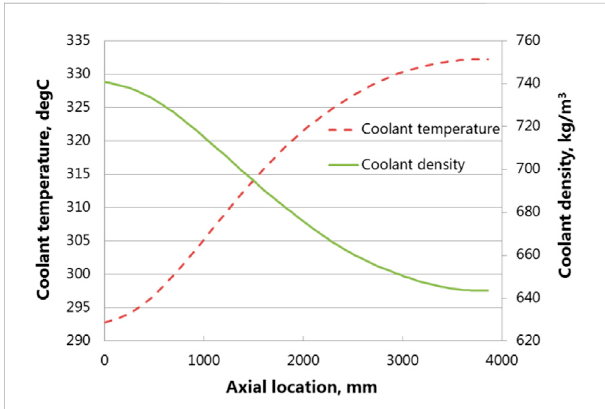
FIGURE 11 Coolant temperature and density distribution after convergence.